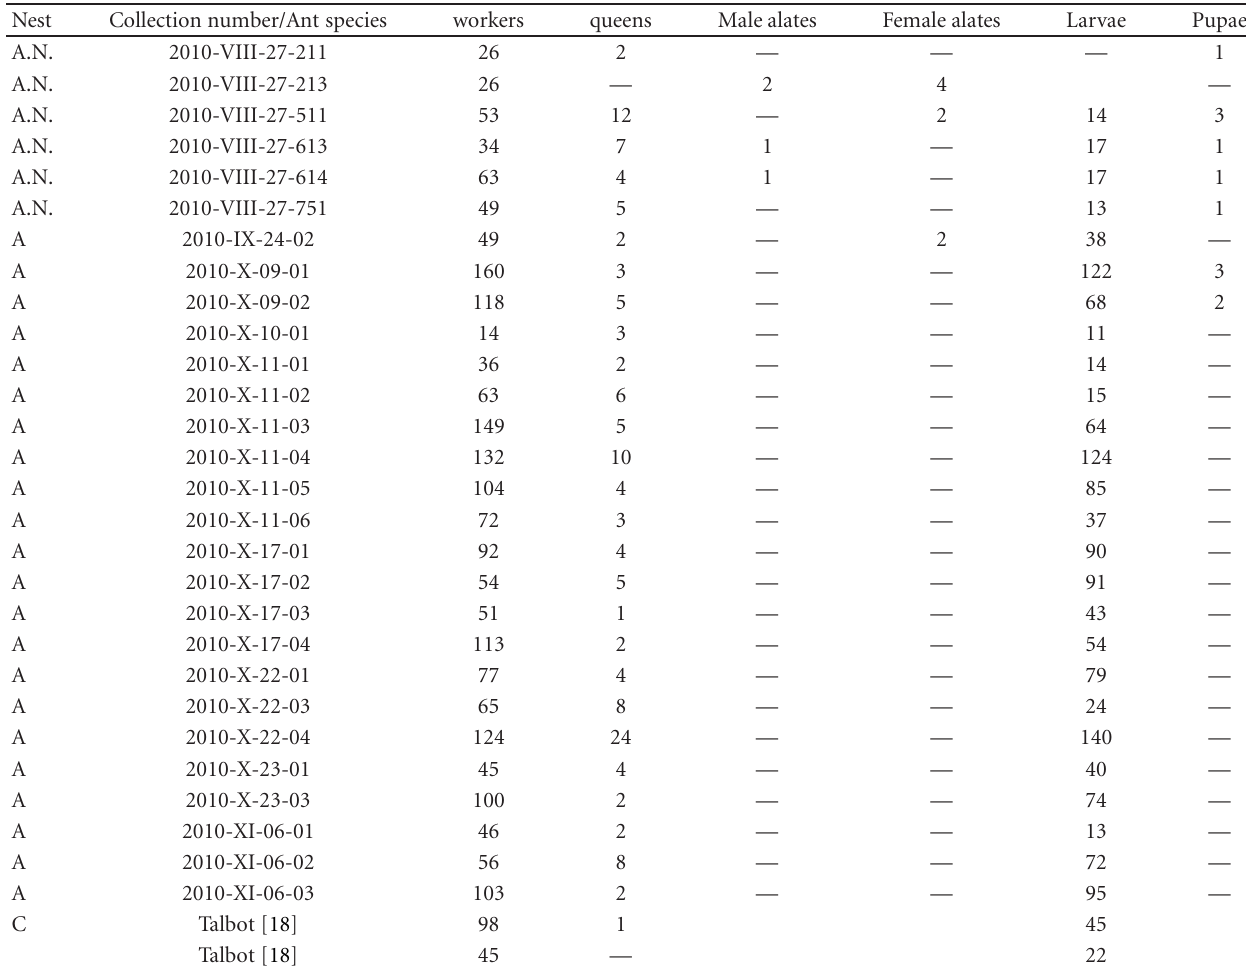
Table 1: Demographic data for Pyramica rostrata colonies recovered in this investigation [Montgomery Co., Maryland]. Nest